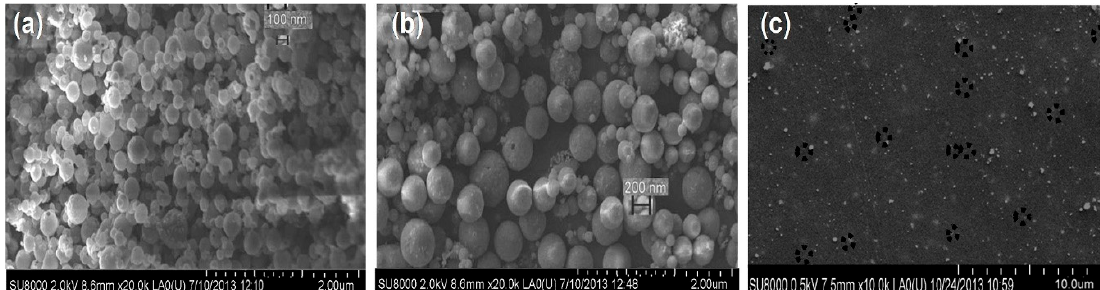
Figure 4. SEM images of: ( a ) as synthesized ZnO nanoparticles; ( b ) chitosan-modified ZnO nanoparticles; ( c ) cured castor oil/chitosan-modified ZnO nanocomposite (7.5 wt %). Reprinted from [18], copyright 2015, with permission from the American Chemical Society.